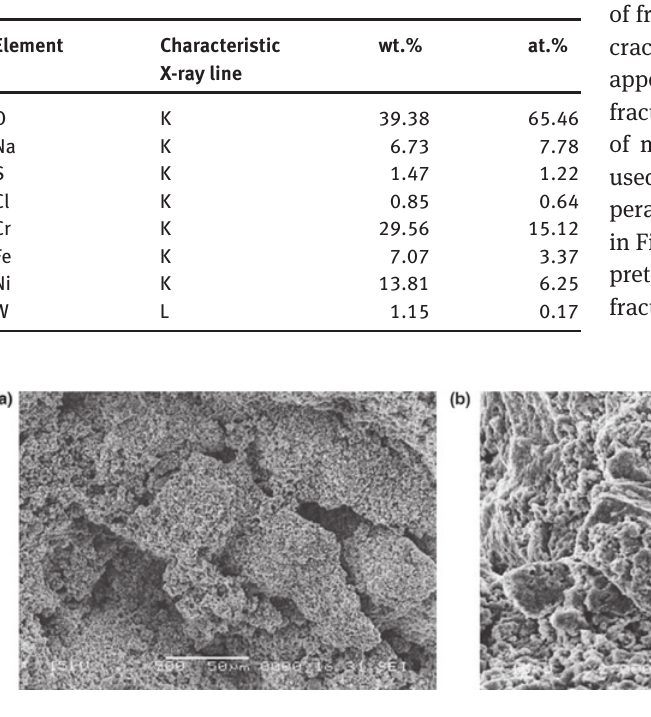
Fig. 9: Scanning electron micrographs: (a) general view of creep crack, and (b) general view of fracture crack surface [21].